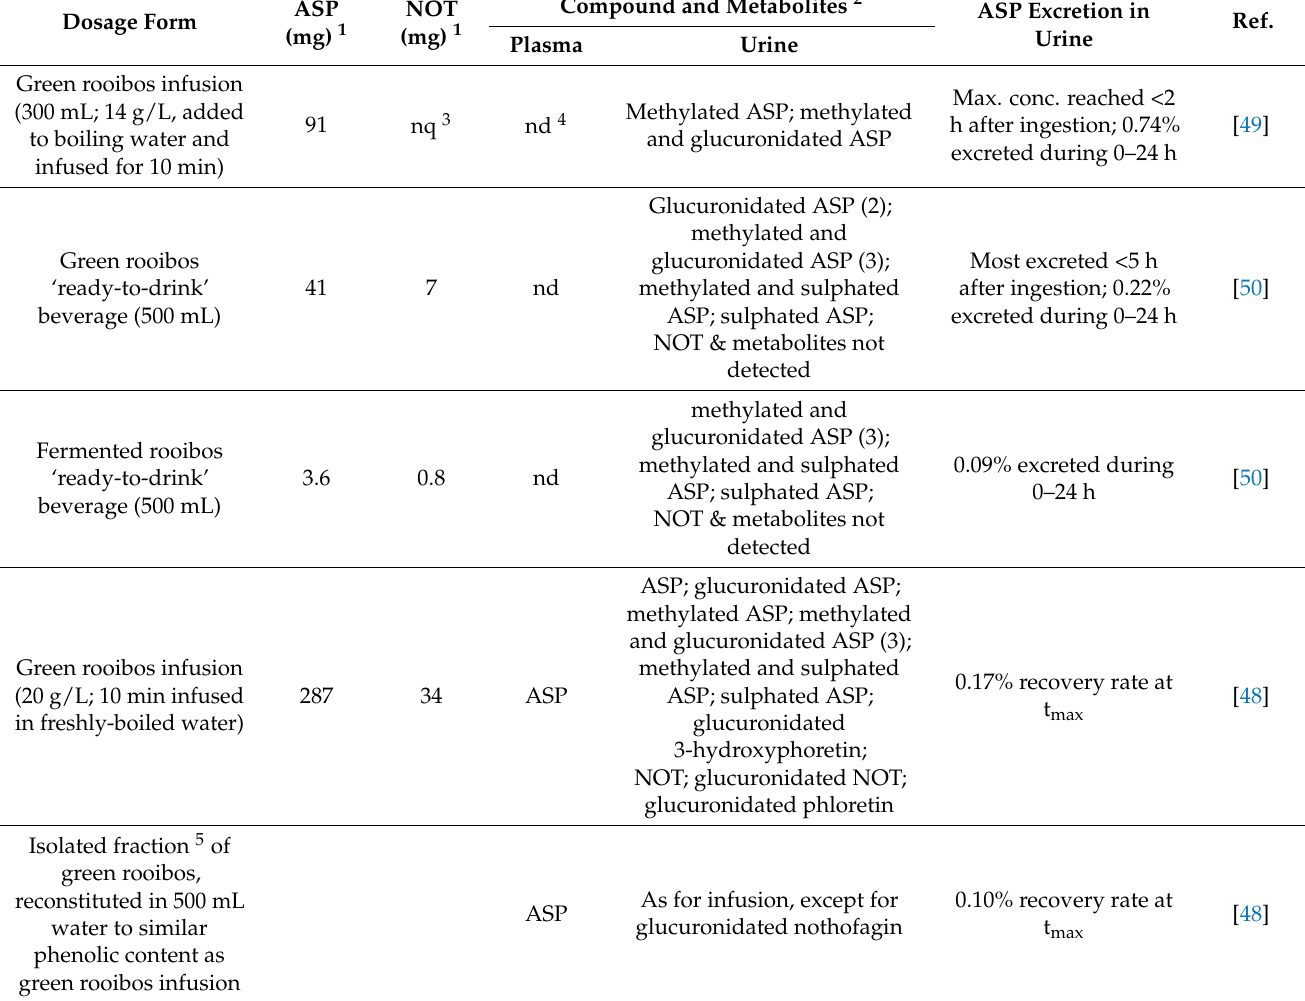
Table 2. Bioavailability studies of aspalathin (ASP) and nothofagin (NOT) in human subjects after a single